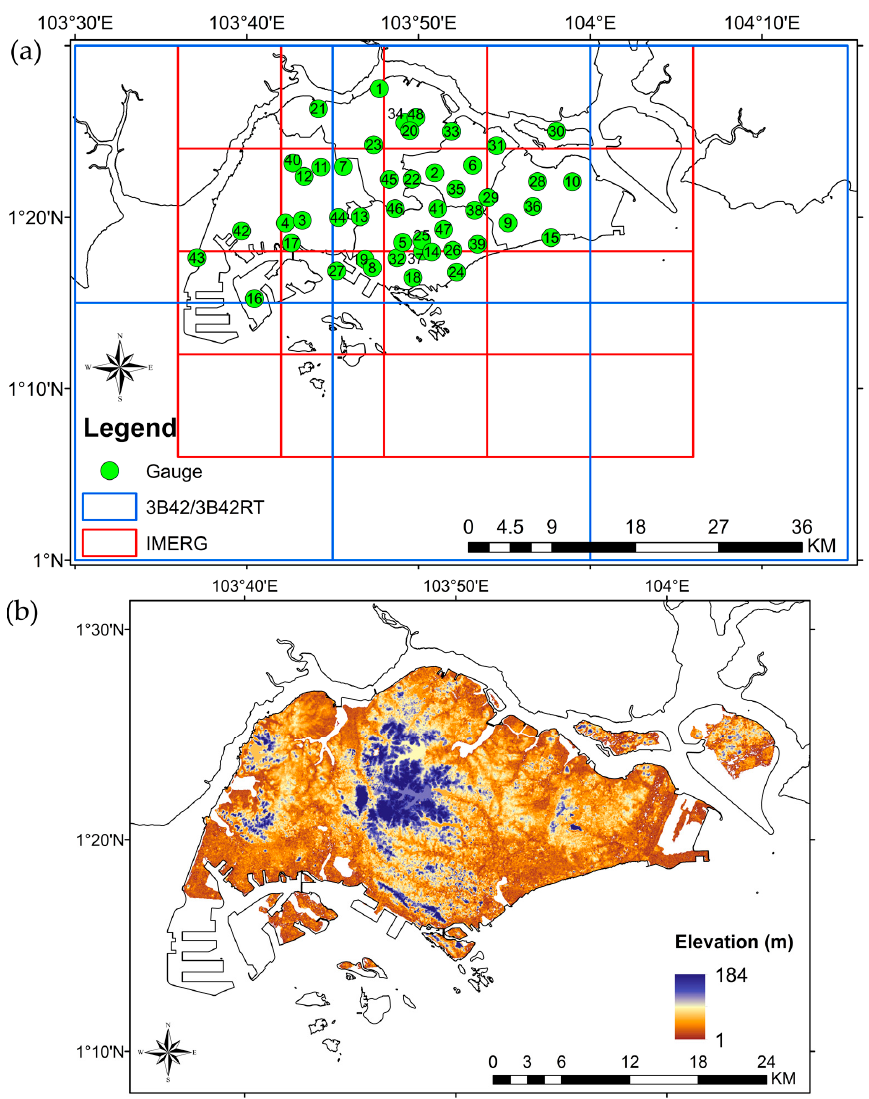
Figure 1. ( a ) Locations of rain gauge stations and the spatial coverage of a single grid from TRMM Multisatellite Precipitation Analysis (TMPA) (TRMM = Tropical Rainfall Measuring Mission) and Integrated Multi-satellite Retrievals for GPM (IMERG) products (GPM = Global Precipitation Measurement) (the blue grid represents the 3B42 or 3B42RT product, and the red grid represents IMERG) and ( b ) topography map of Singapore.